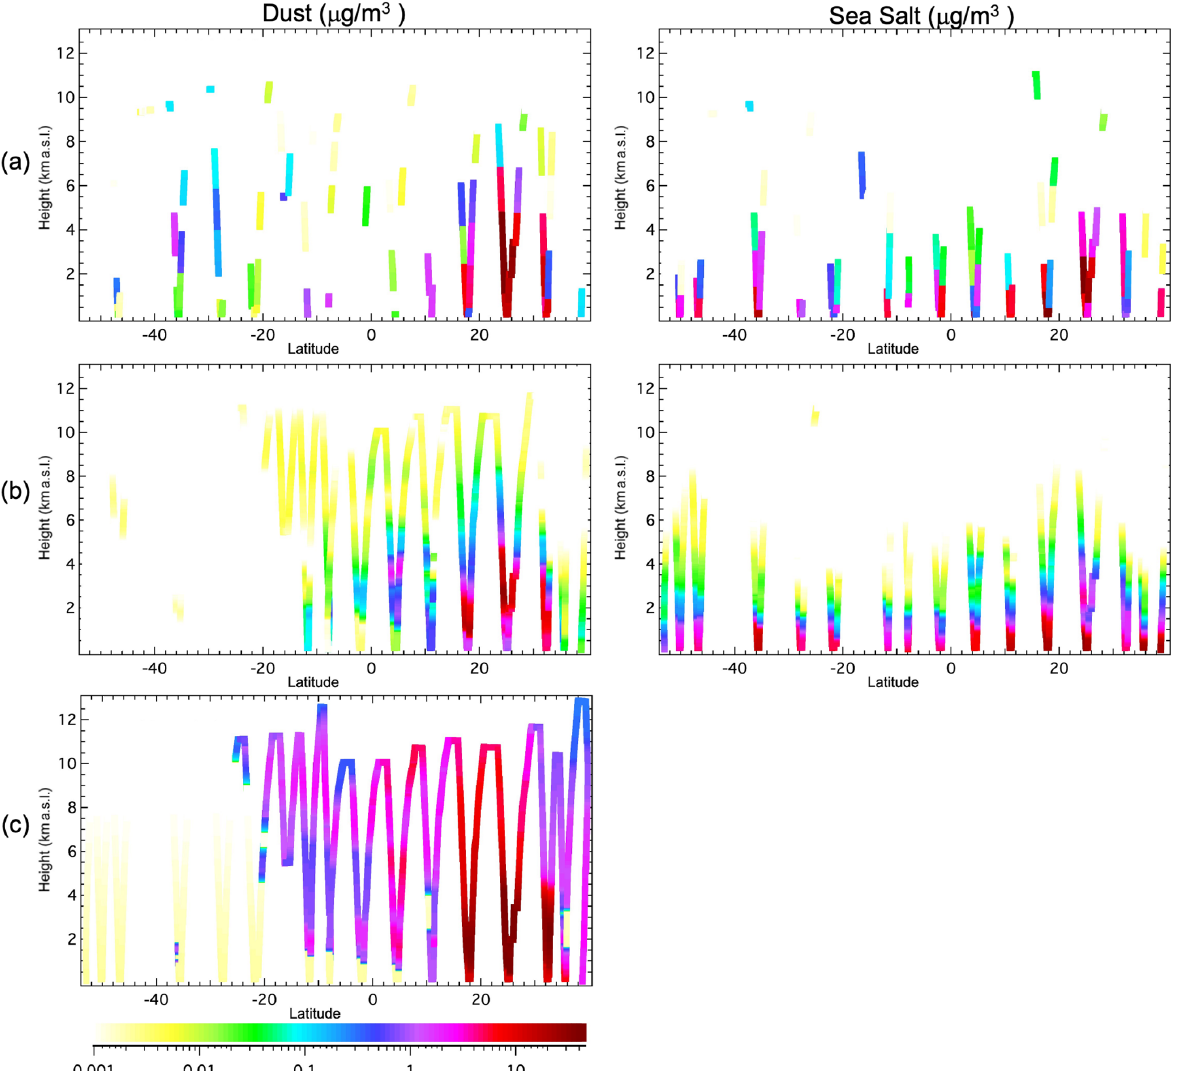
Figure 19. Height–latitude profiles of dust ( < 3.0µm diameter) and sea salt ( < 3.0µm diameter) over the Atlantic on 15 and 17 August 2016 for (a) the ATom-1 DC-8 observations and (b) GEFS-Aerosols and (c)